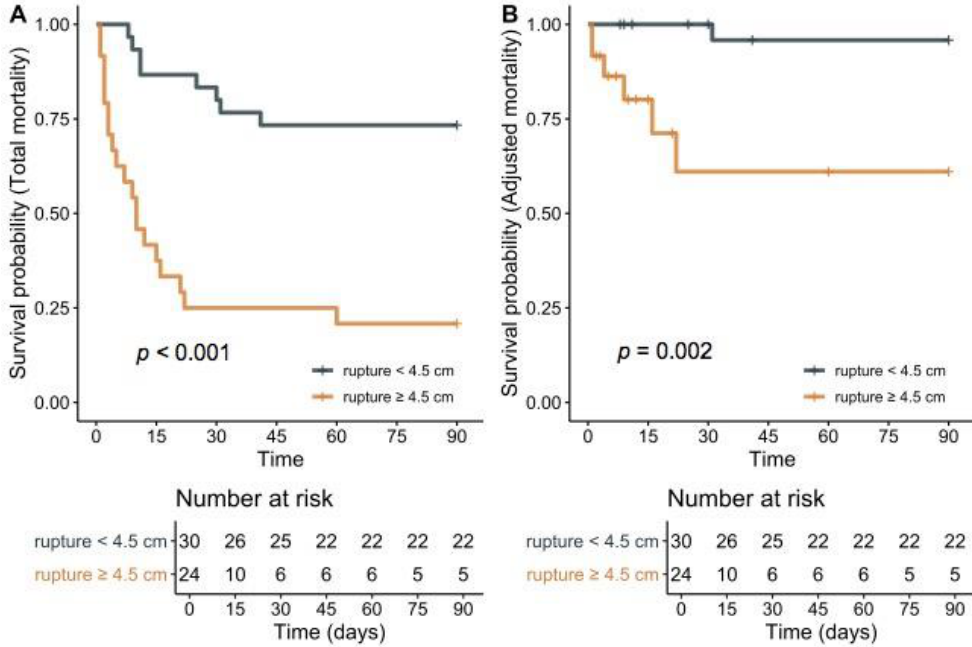
Figure 3. Kaplan–Meier curves in patients with rupture lengths of < 4.5 cm vs. ≥ 4.5 cm for all-cause mortality-free survival (( A ); log rank p < 0.001) and adjusted mortality-free survival (( B ); log-rank p = 0.002).